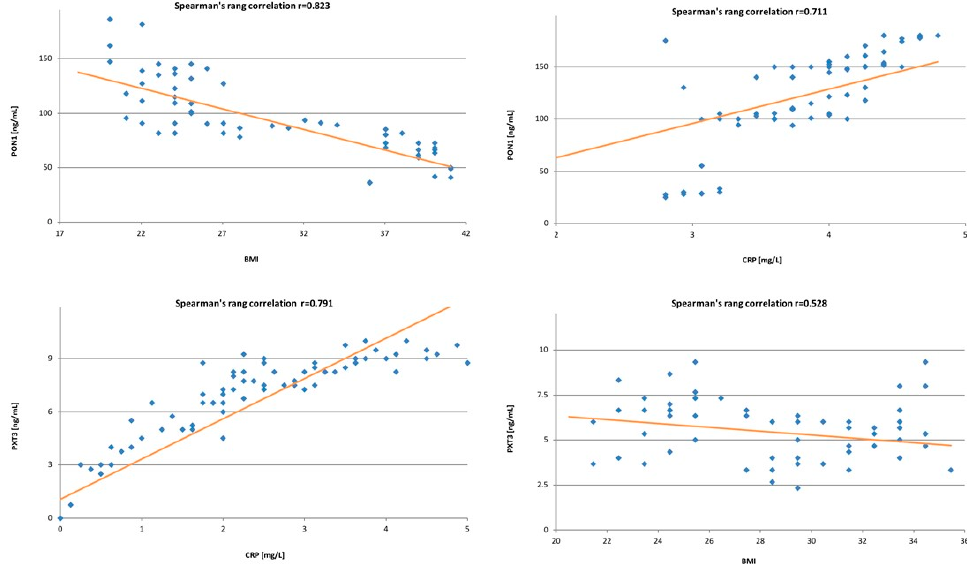
Figure 1. Spearman’s correlations between the levels of studied proteins and patients’ BMI and CRP levels. On the ( top ), figures demonstrate correlations for PON1, while on the ( bottom ), figures demonstrate correlations for PTX3.